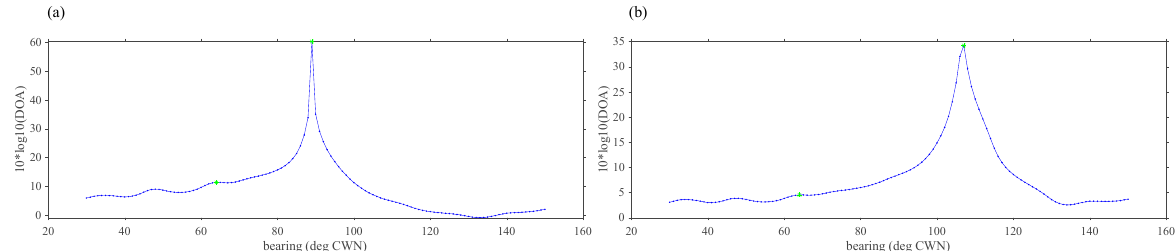
Figure 10. Two consecutive direction-finding results using the MUSIC algorithm; the green dots are the DOAs of ship 1: (a) At 7:59 on 29 October 2013 (UTC); (b) At 8:16 on 29 October 2013 (UTC).